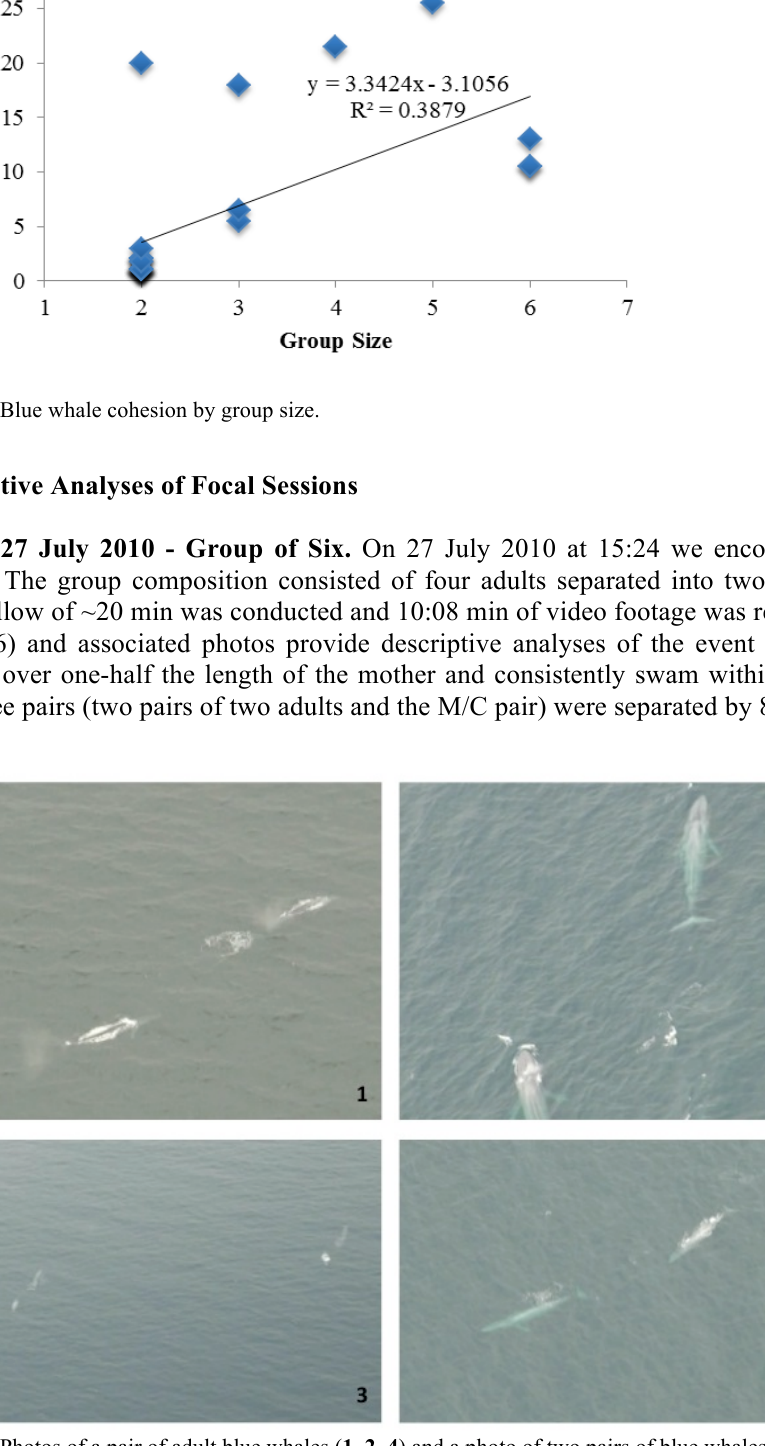
Figure 4. Photos of a pair of adult blue whales ( 1, 2, 4 ) and a photo of two pairs of blue whales ( 3 ) within a group of six blue whales on 27 July